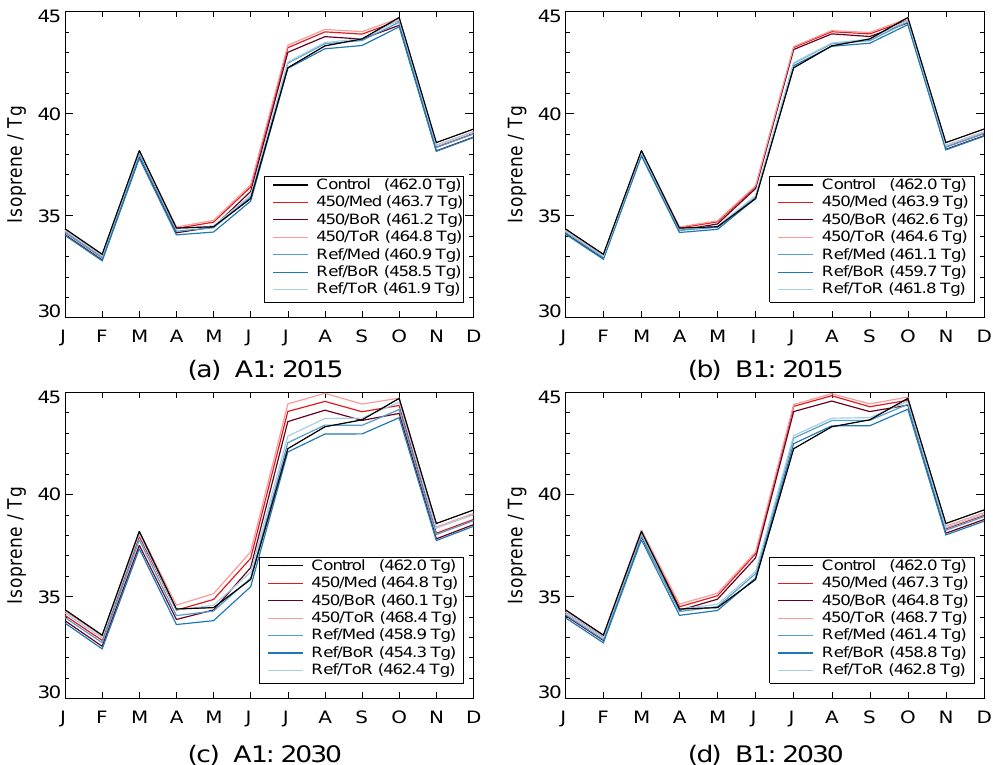
Fig. 4. Monthly isoprene emissions (Tgmonth − 1 ) for realizations corresponding to the median, top-of-the-range (ToR) and bottom-of-the- range (BoR) in 2015 for A1 (a) and B1 (b) and in 2030 for A1 (c) and B1 (d) . The 450 biofuel scenarios are shown in red and the Reference scenarios are shown in blue. The ZLUC scenario is shown in